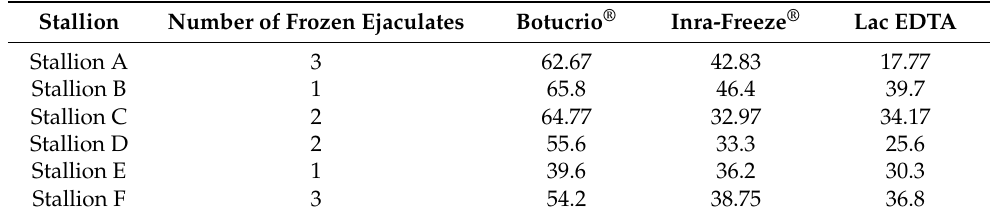
Table 5. Mean progressive motility values (%) 5 min after thawing for freezing extenders and stallion.